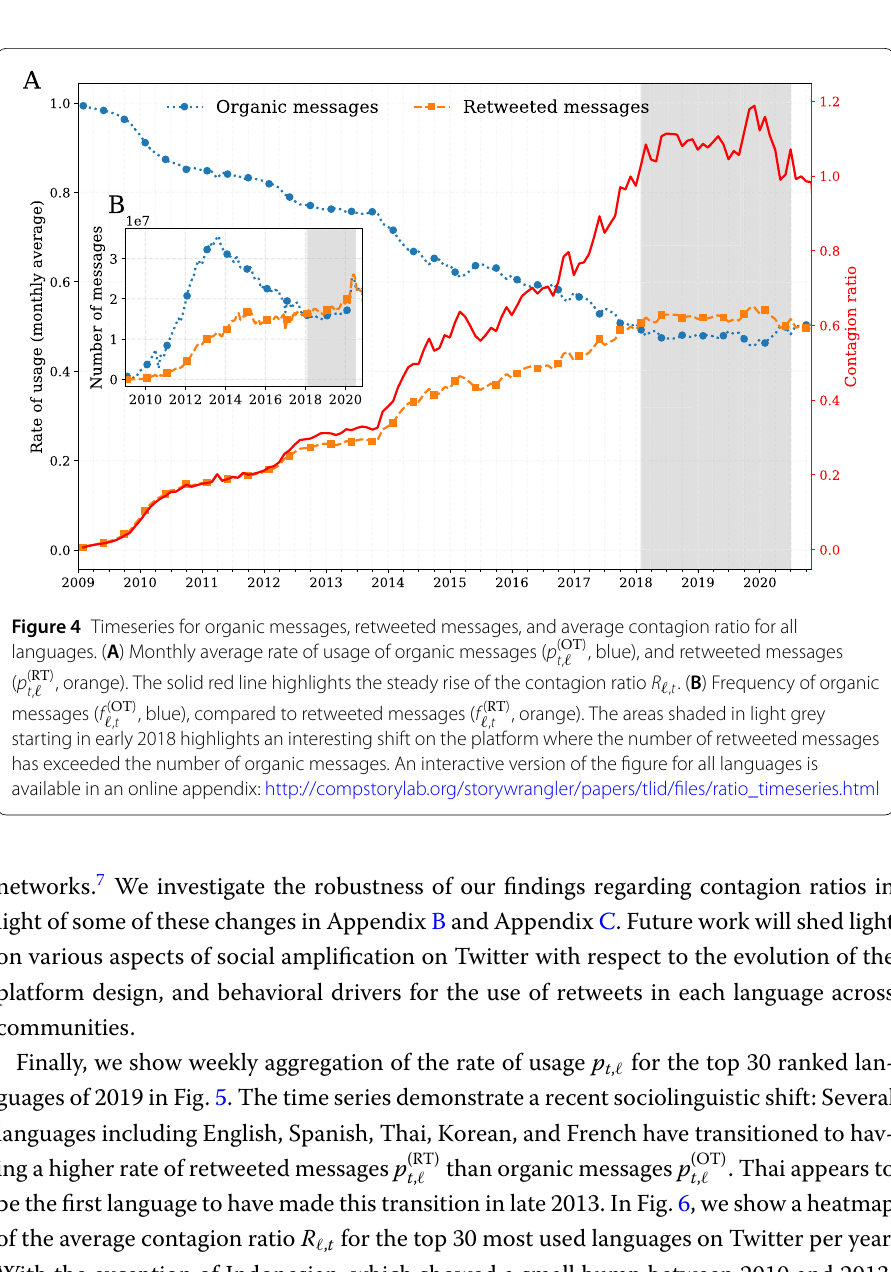
, blue), and retweeted messages t , (cid:2) , orange). The areas shaded in light grey (cid:2) , t